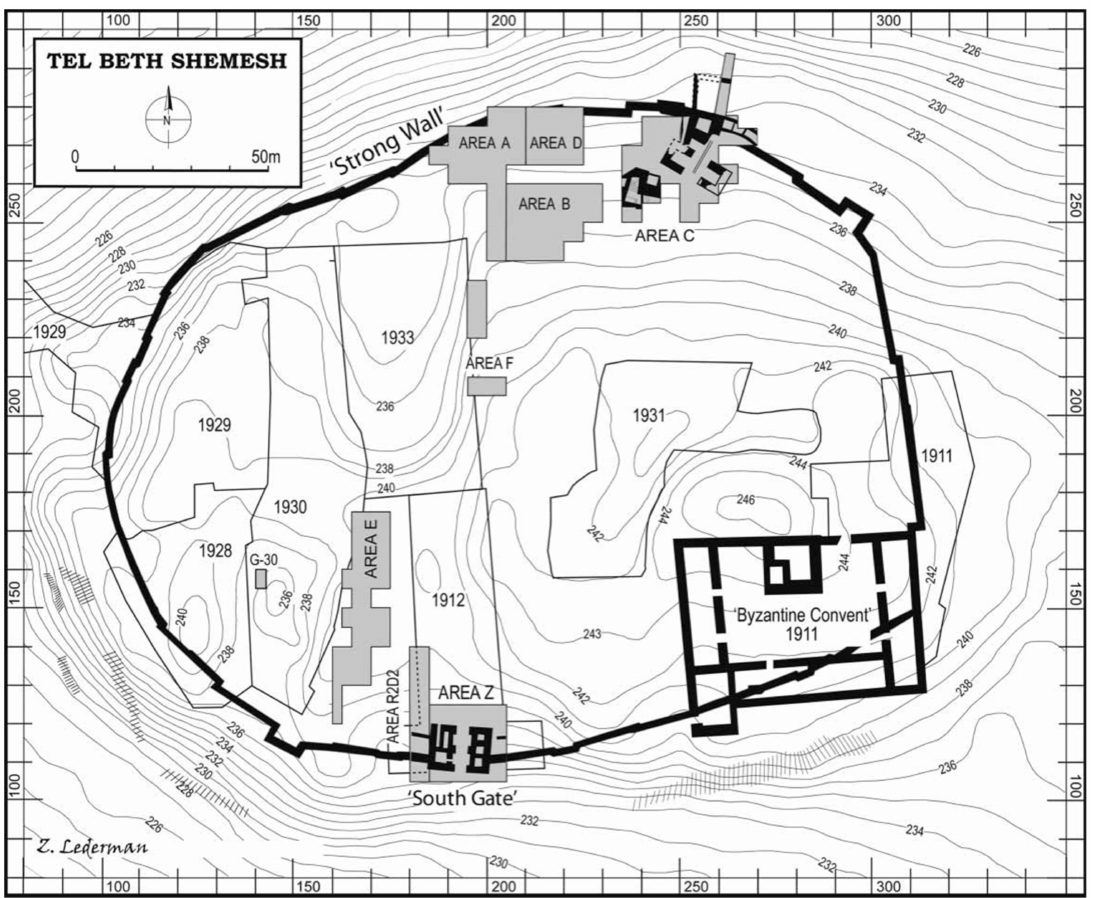
Figure 3. A plan of the mound of Tel Beth-Shemesh, with excavation areas marked. Despite the wide exposure of Iron II levels (in practice, all excavation areas, noted on the plan), no temples were uncovered (Bunimovitz and Lederman 2013, p. 7; courtesy of the Tel Beth-Shemesh excavations